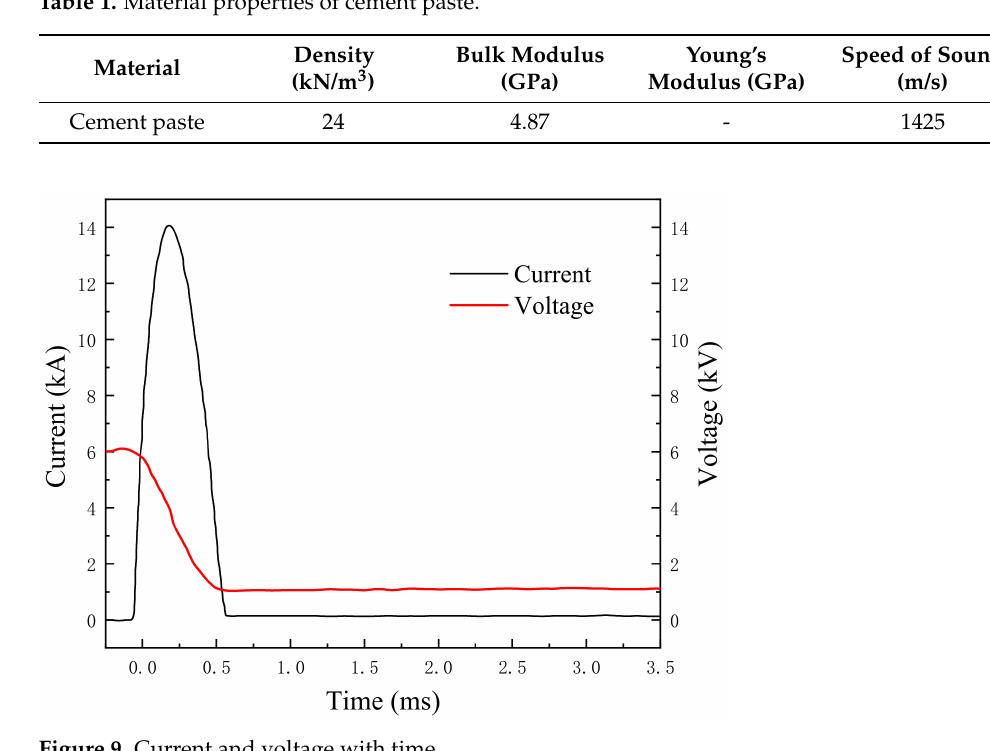
Table 1. Material properties of cement paste.